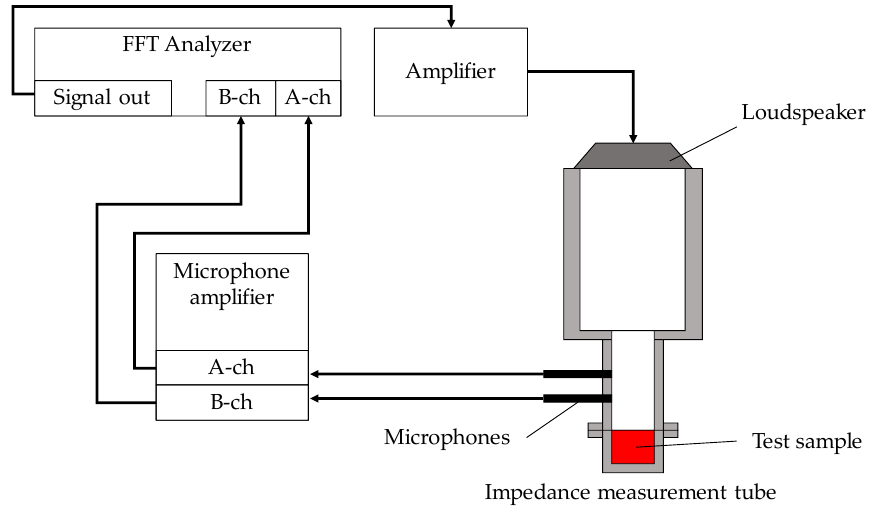
Figure 2. Scheme of two microphone impedance tubes for the sound absorption coefficient meas- urement.